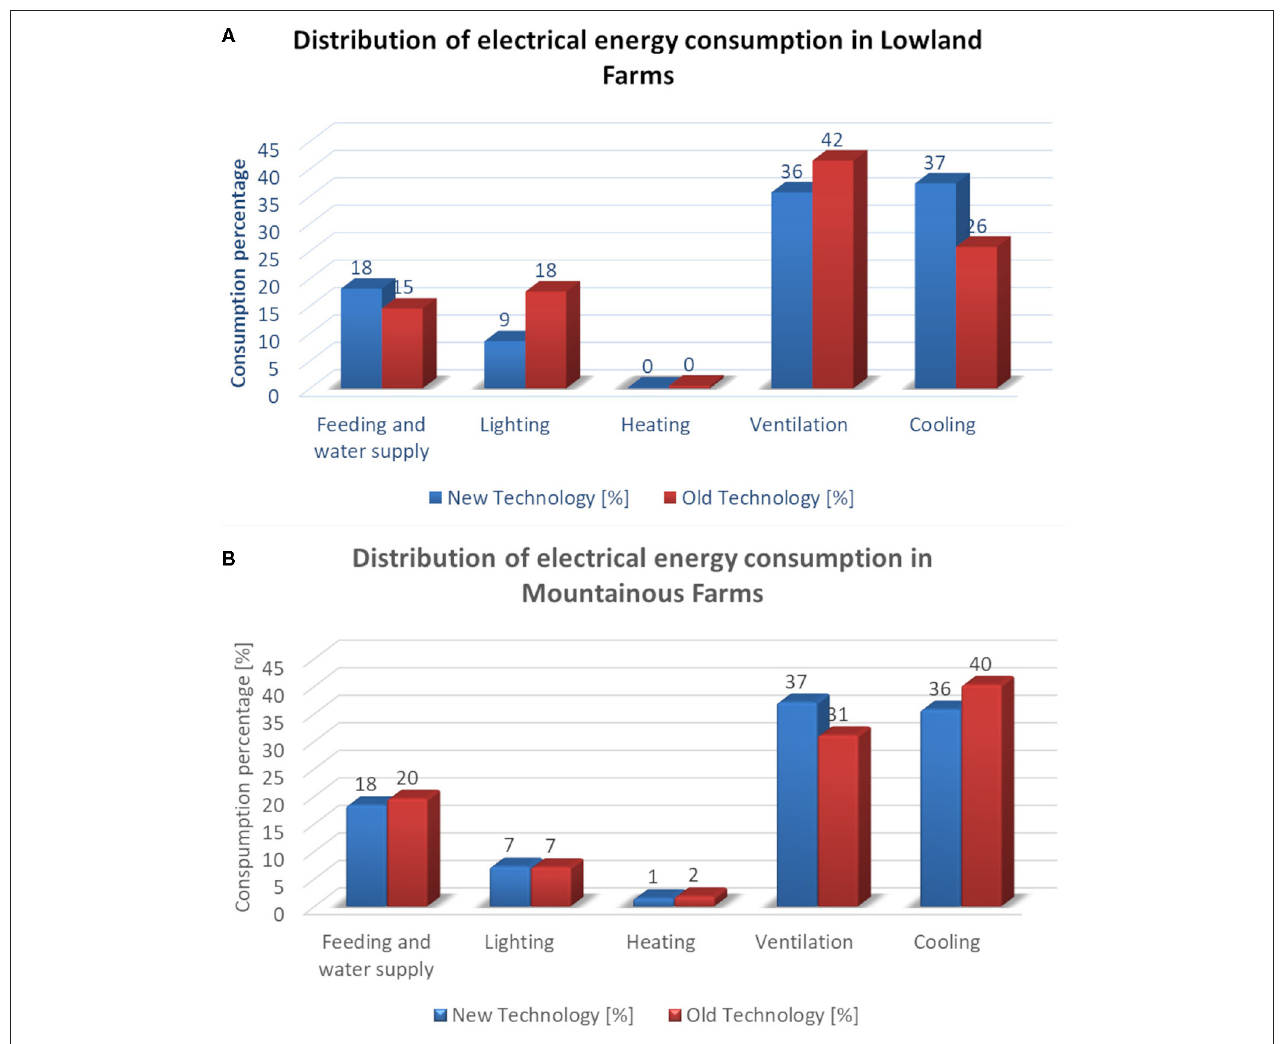
FIGURE 8 | Distribution of electrical energy consumption (A) in lowland farms and (B) in mountainous farms, for new and old technology